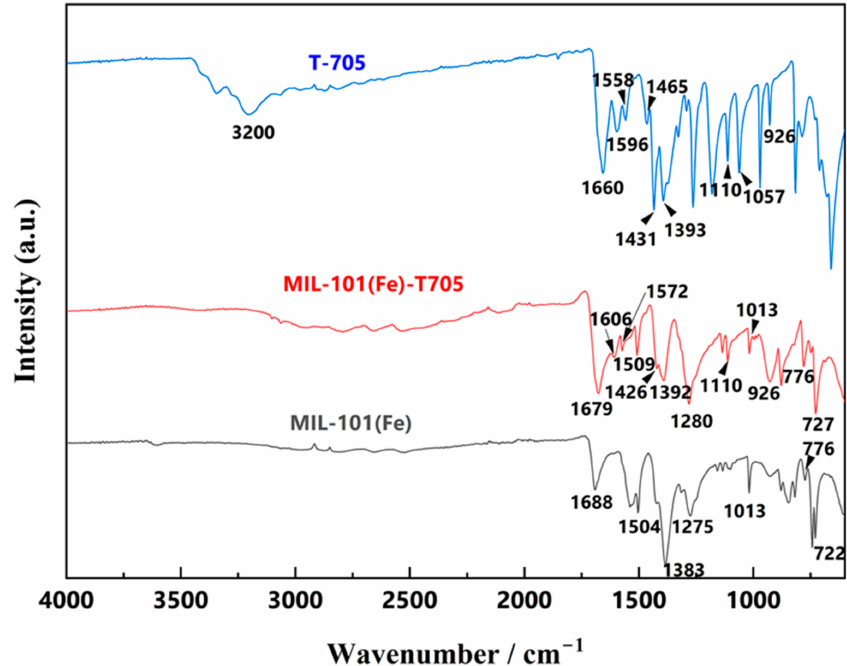
Figure 3. FT-IR spectra of the as-synthesized